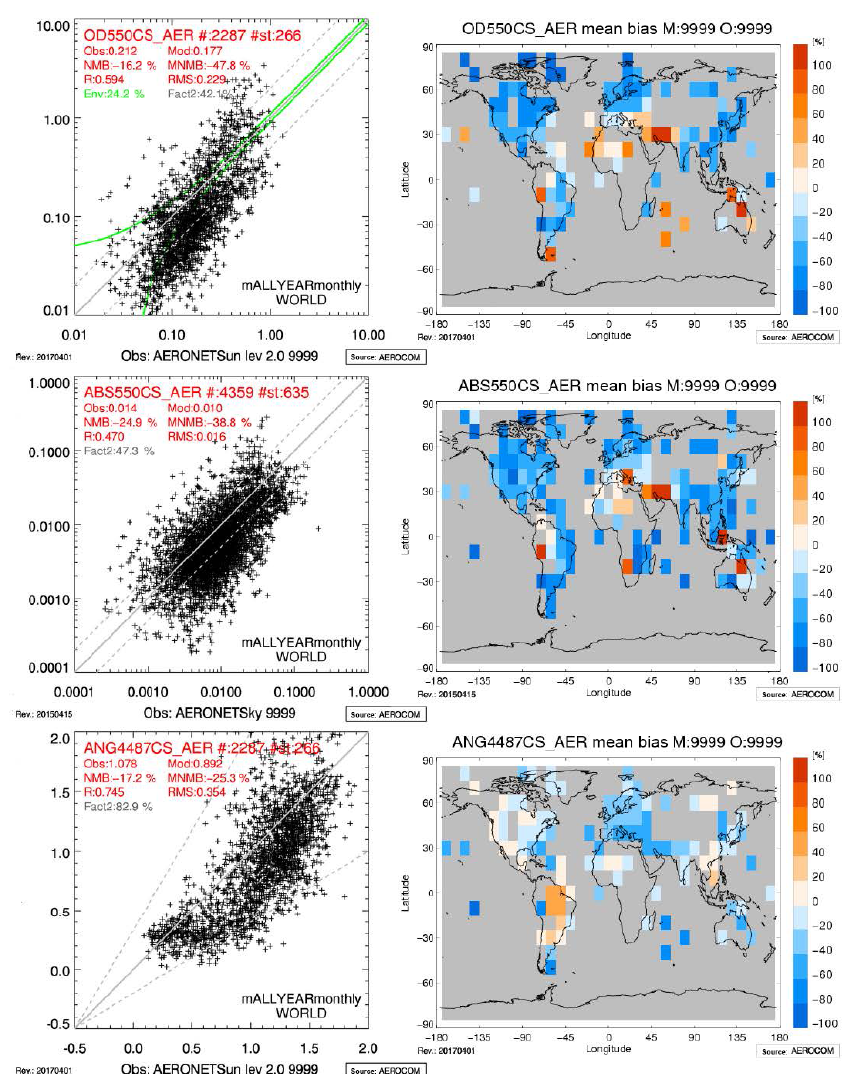
Figure 7. Scatter plots (left panels) and annual relative bias plots with respect to AERONET observations and retrievals (right panels) of clear- sky aerosol optical depth (top), all-sky absorption optical depth (middle) at 550nm, and Ångström parameter (bottom) for the wavelength range 440–870nm for the NUDGE_PD